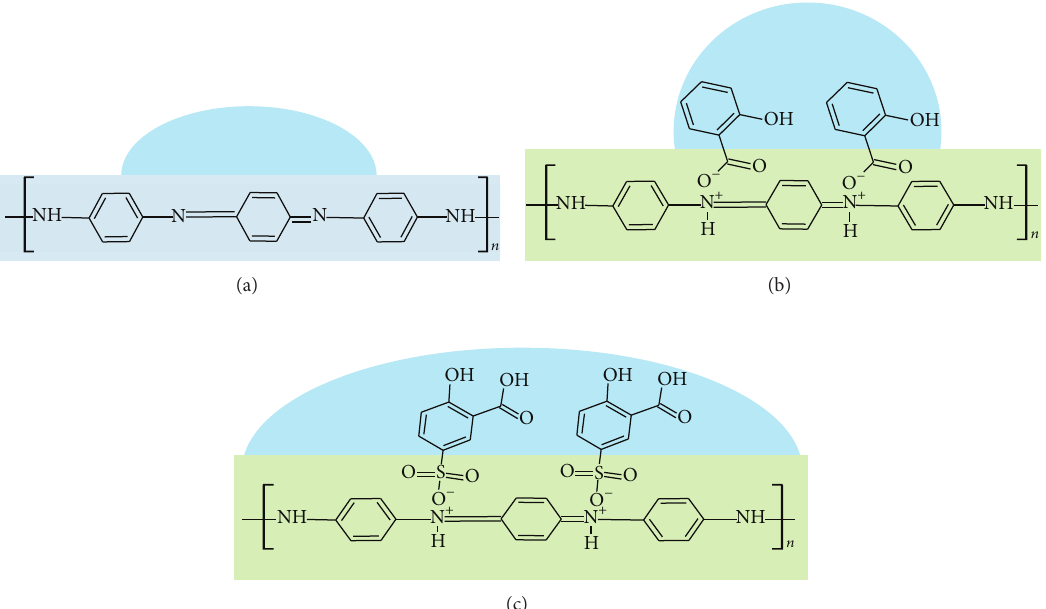
Figure 5: Proposed mechanism for the wettability observed for (a) P4ADPA B, (b) P4ADPA/SA, and (c) P4ADPA/SSA films.